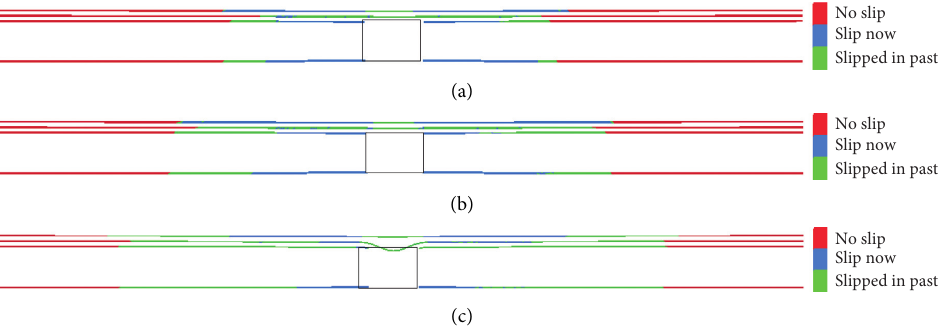
Figure 9: Interface slip of different horizontal stresses: (a) 20MPa, (b) 30MPa, and (c) 40MPa.